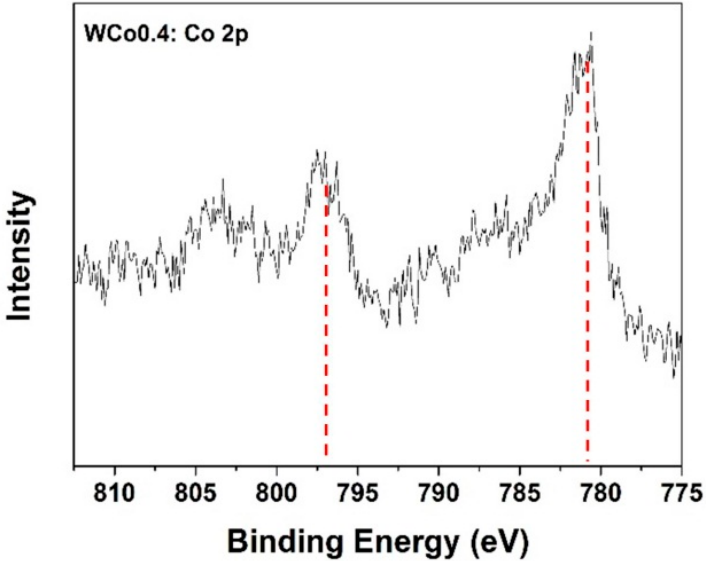
Figure 5. X-ray photoelectron spectroscopy (XPS) spectra of Co 0.4 Mg 1.6 SiO 4 samples showing binding energy of Co 2p.